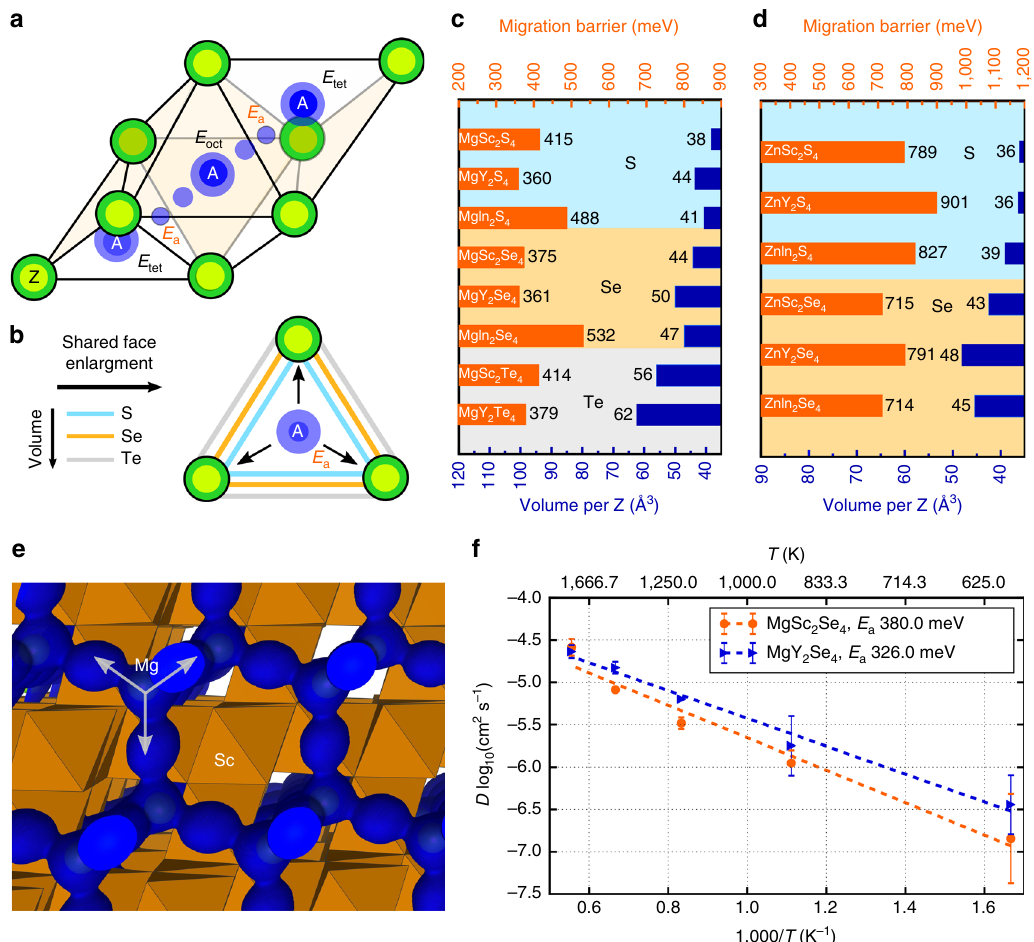
Fig. 1 First-principles Mg and Zn migration barriers in sul fi des, selenides, and tellurides AX 2 Z 4 spinels (with A = Mg or Zn). a tet – oct – tet migration path in the AX 2 Z 4 framework, with energy of the tet , oct , and transition sites indicated by E tet , E oct , E a , respectively. E a corresponds to the migration energy. b Effect of the anion size on the shared (triangular) face between tet and oct sites. c and d computed Mg and Zn migration barriers (orange bars in meV) in AX 2 Z 4 spinel and volume per anion (blue bars), respectively, with X = Sc, Y, and In, and Z = S, Se and Te. e Mg probability density in MgSc 2 Se 4 at 900 K obtained from ab initio molecular dynamic simulations (AIMDs). f Mg diffusivities as extrapolated from AIMD in MgSc 2 Se 4 (orange) and MgY 2 Se 4 (blue), with dashed lines and error bars indicating Arrhenius fi ts and SD, sul fi des and selenides, such as MgY 2 S 4 , MgIn 2 Se 4 , ZnSc 2 Se 4 , and ZnIn 2 Se 4 , as well as the tellurides (MgSc 2 Te 4 , MgY 2 Te 4 ) have not been synthesized to date. The Mg migration barriers, E a in Fig. 1c indicate that the fastest Mg conductors are MgY 2 S 4 (~ 360 meV),